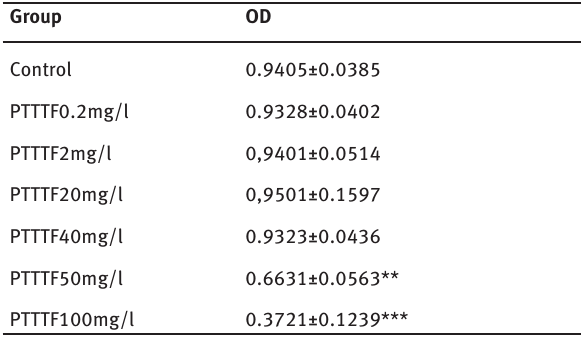
Table 1: Toxic effects of PTTTF on RAW264.7 cells. Group